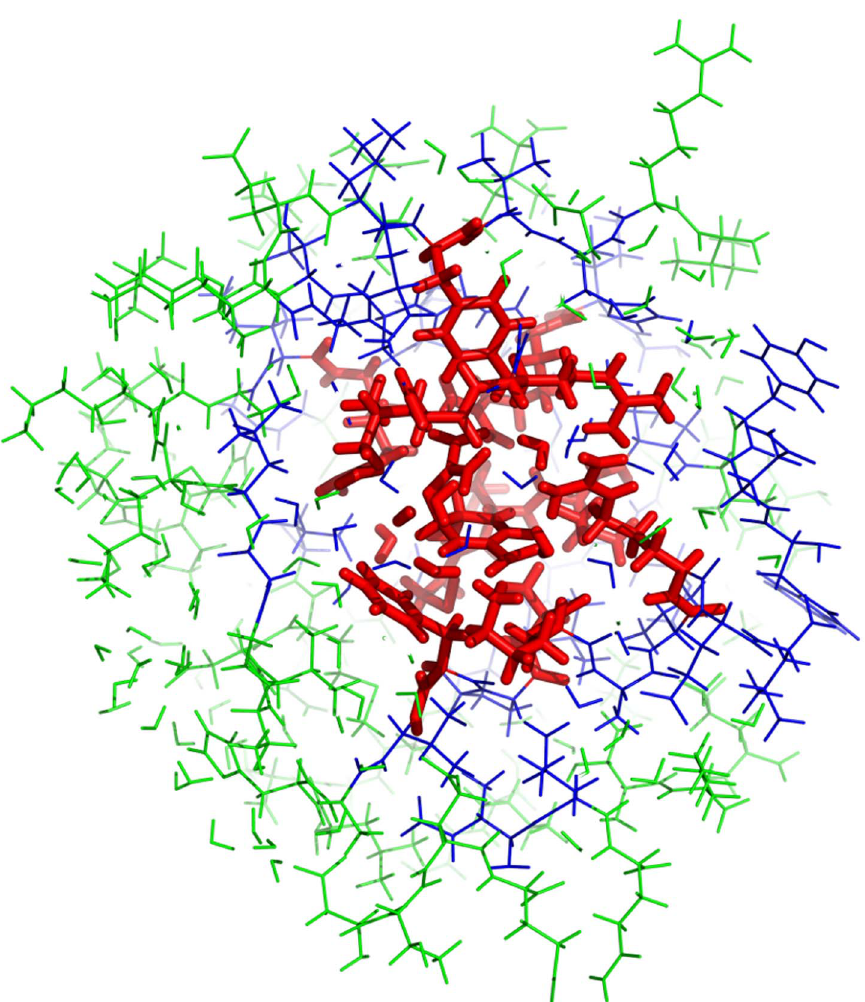
Figure 5. EFMO:L model of chorismate mutase used in this study. The entire model contains 2398 atoms. There are 1006 atoms in green belonging to the frozen region ( F ), 1151 atoms in blue belonging to the buffer region ( b ) and 241 atoms in red belonging to the active region ( A ).